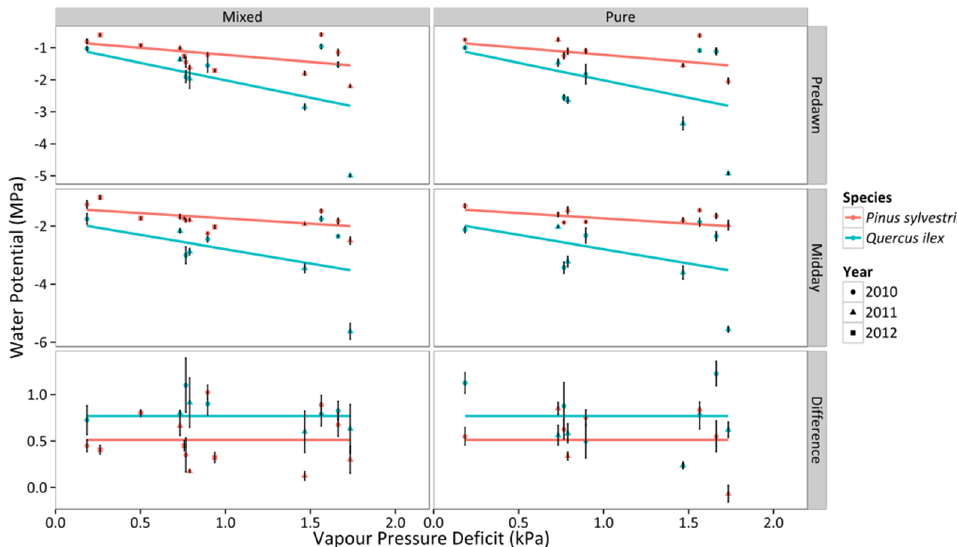
Figure 2. Responses of Ψ PD , Ψ MD , and ΔΨ to daytime averages of VPD in two different stand types throughout three consecutive years. Average values for P. sylvestris and Q.